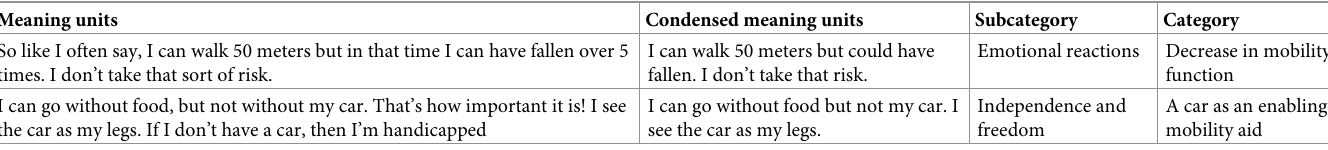
Table 1. Examples illustrating the coding